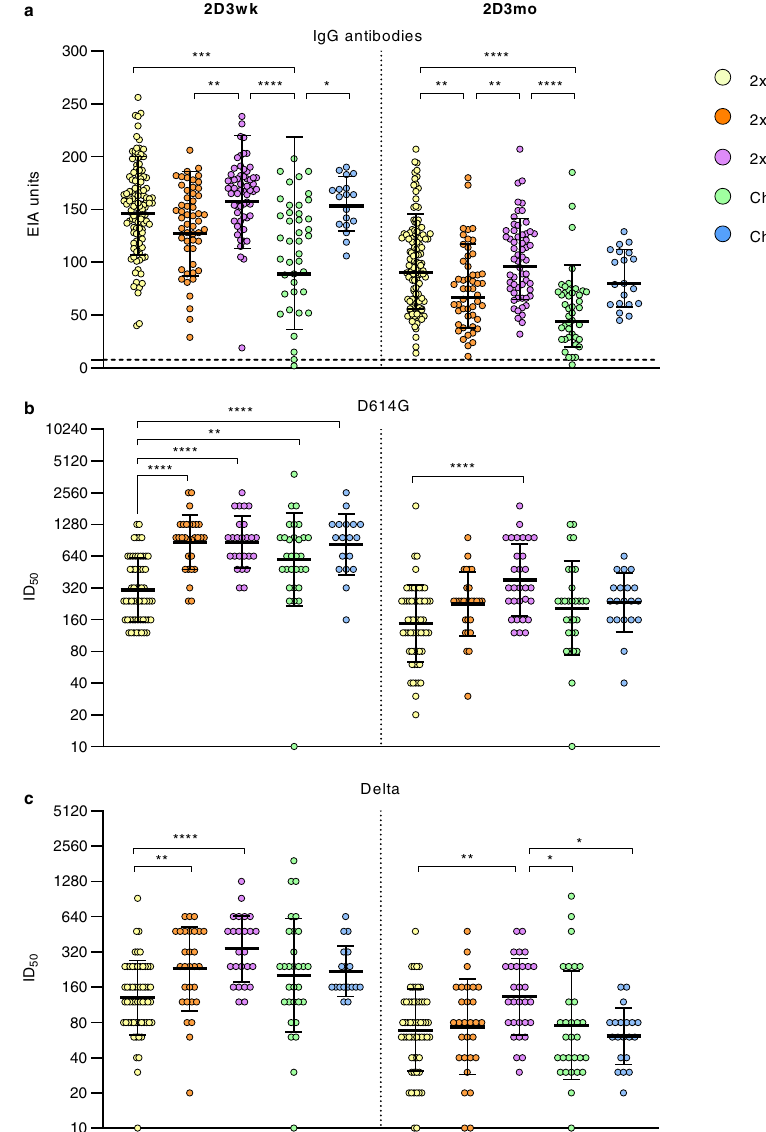
Fig. 5 SARS-CoV-2 neutralizing antibodies after two doses of different combinations of COVID-19 vaccines. a Serum samples collected 3 weeks (2D3wk) and three months (2D3mo) after the second vaccine dose from HCWs who were vaccinated with 2x BNT162b2 with a short ( n = 120) or a long vaccine dose interval ( n = 59), 2x mRNA-1273 ( n = 67), ChAdOx1 + BNT162b2 ( n = 47), or ChAdOx1 + mRNA-1273 ( n = 21) were compared for anti-SARS- CoV-2 S1 IgG antibodies (EIA units). The dotted line indicates the cut-off value. Neutralizing antibody responses against b D614G and c Delta variants were analysed for vaccinees with two doses of vaccine combinations: 2x BNT162b2 with a short ( n = 59), or a long vaccine dose interval ( n = 29), 2x mRNA-1273 ( n = 25 at 2D3wk and 30 at 2D3mo), ChAdOx1 + BNT162b2 ( n = 30), or ChAdOx1 + mRNA-1273 ( n = 18 at 2D3wk and 20 at 2D3mo). Half-maximal inhibitory dilutions (ID50) were calculated and titers <20 were marked as 10. Geometric mean titers (GMTs) for each vaccine group are shown as lines with geometric SDs. Differences in IgG antibody levels and neutralization titers between different groups were analysed with two-sided Kruskal – Wallis rank test and P -values <0.05 were considered statistically signi fi cant. P -values: <0.0001 are marked with ****, from right to left in panel a 0.0001 ***, 0.0019 **, and 0.0215 *, from right to left in panel b 0.0023 ** and ** 0.0014, and from right to left in panel c 0.0096 **, 0.0098 **, 0.0307 *, and 0.0122